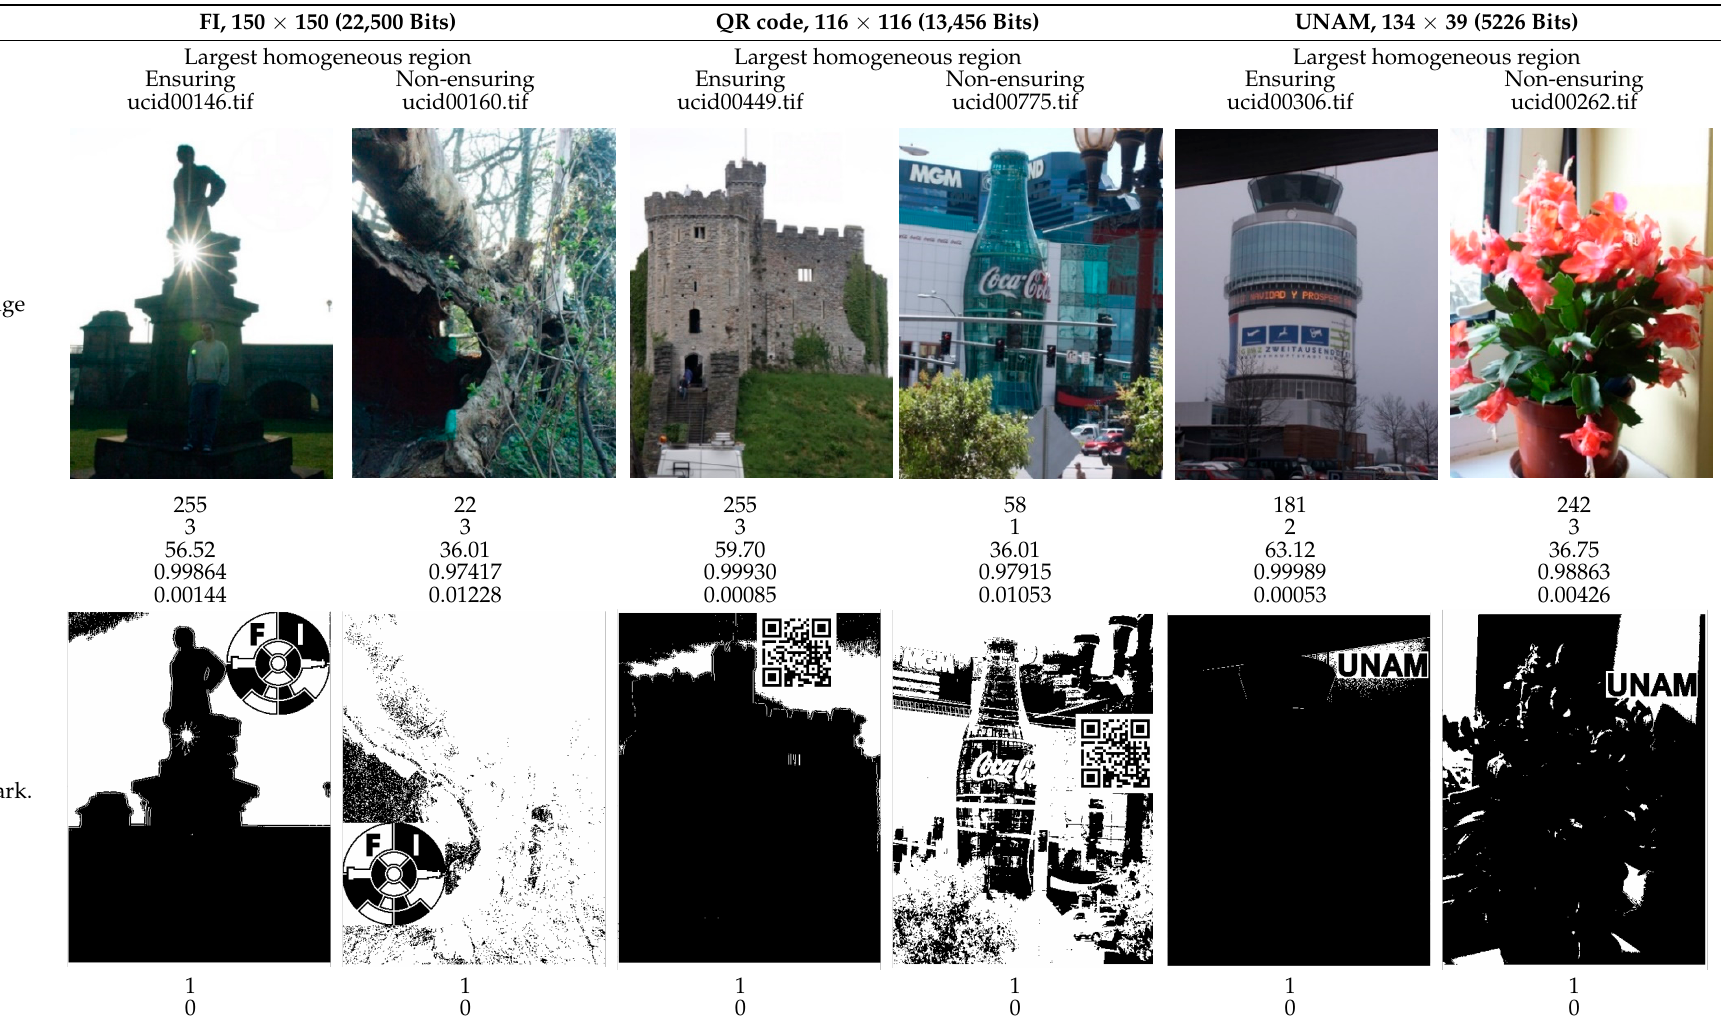
Table 4. Visual quality degradation and imperceptibility of non-attacked watermarked images.